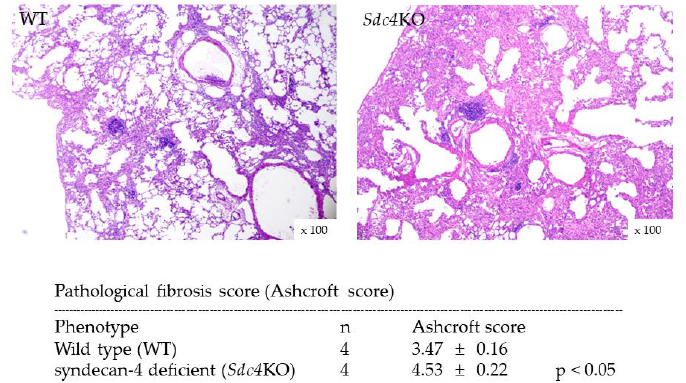
Figure 3. Histopathological findings at 21 days after intratracheal bleomycin instillation. Upper figures of hematoxylin and eosin staining were representatives of four mice. Pathological lung fibrosis score of the syndecan-4-deficient mice ( Sdc4 KO) was significantly higher compared to wild-type mice (WT) at 21